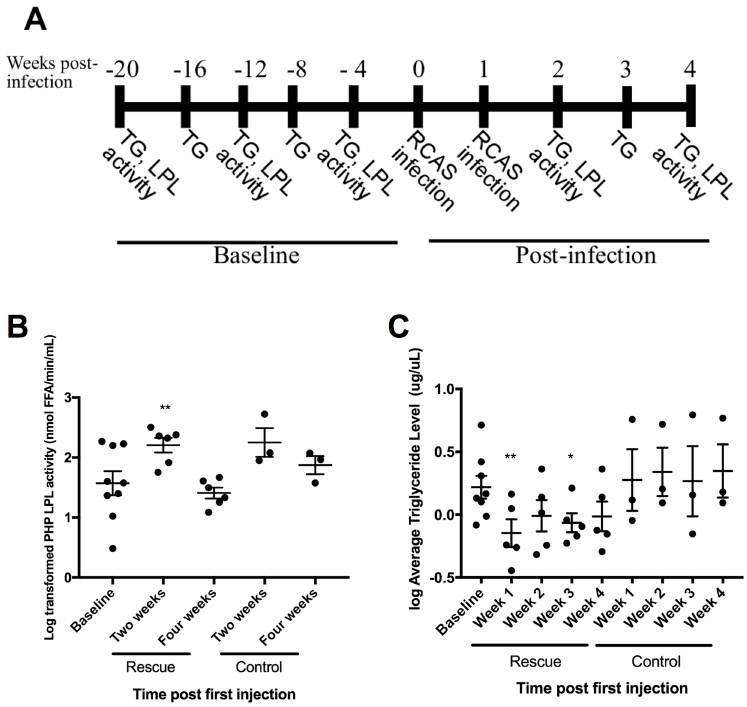
Fig 4. In vivo RCAS-hLPL infection decreaseshigh triglyceride levels in hypertriglyceridemic mice. A. A schematic showingthe timing measurements for fasting serum triglycerides(TG) or post-heparin LPL activity (PHP LPL) taken prior to (baseline)and following(post-infection) injectionof RCAS-hLPL or RCAS- mCherry producing cells. Fasting serum triglycerides(TG) were measuredat all indicatedtime points. B. PHP LPL activity was measuredat baseline, week 2 and week 4 post infection. Two weeks post-injection, rescue animalPHP LPL activity is significantly higherthan at baseline(p < 0.02; One-way ANOVA performed on log transformed values). PHP LPL activity beings to declineby one month post-infection, but remainshigherthan baseline. PHP LPL activity levels were normalizedto baselinelevels. Graph shows log transformed values, bars represent the mean of all samples, error bars show +/- SEM. C. Average log transformed fasting serum triglyceride levels from mck-Cre;lpl -/- ;Rosa26 LSLTVA lacZ+/- mice prior (baseline)and weekly post-injection with RCAS-hLPL DF1 cells (rescue; n = 5) or post-injection with RCAS-mCherry DF1 cells (control; n = 3). At one and three weeks post-infection, rescue mice have significantly lower triglyceridelevels comparedto baseline ( * p < 0.05, ** p < 0.02,One-way ANOVA). By four weeks post injection, rescue triglyceridelevels begin to rise, but remainlower than baseline. Triglyceride levels in control mice do not change significantly from